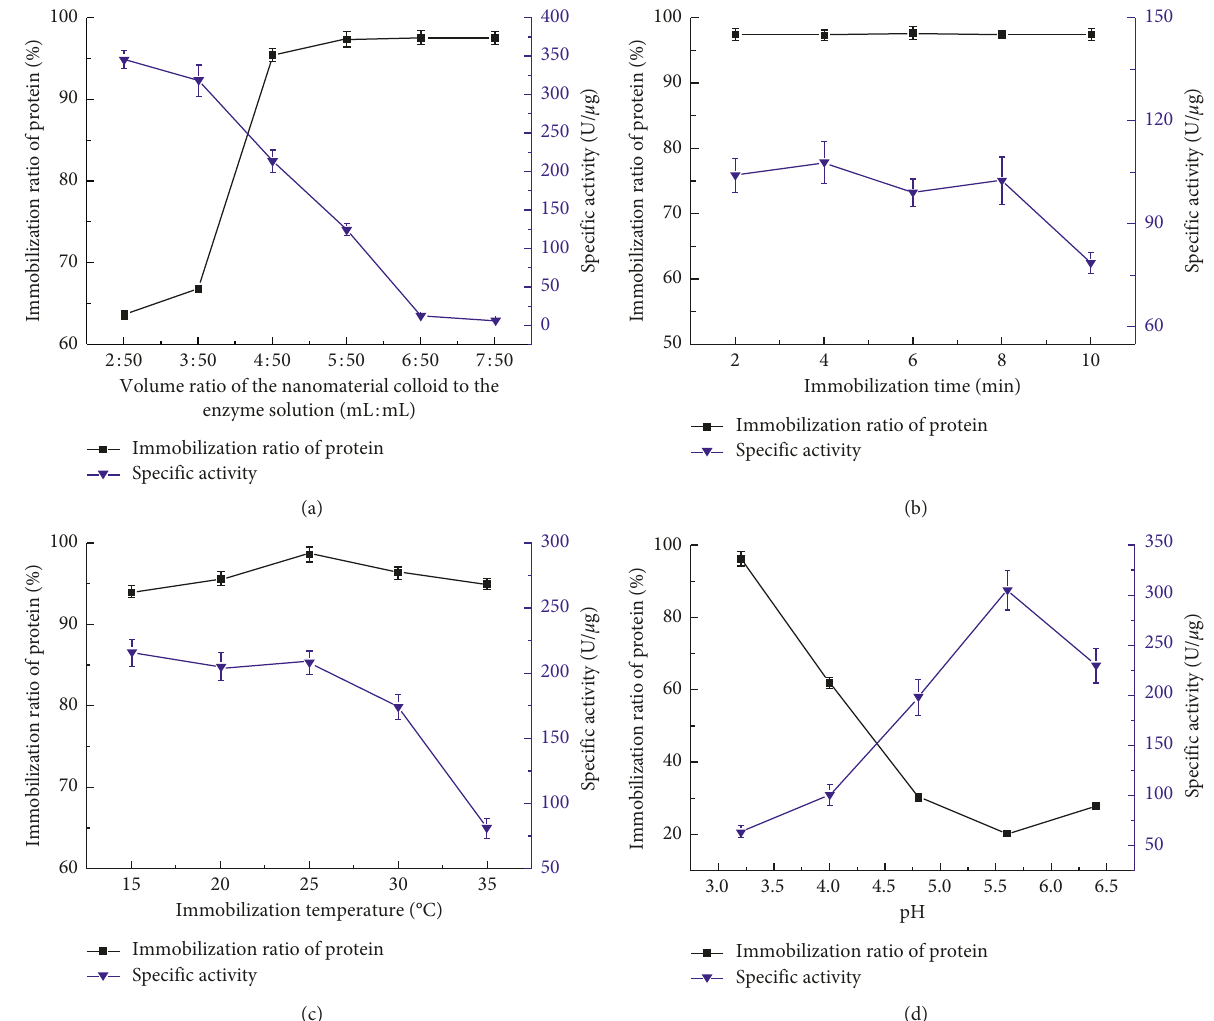
Figure 8: Influence of the volume ratio of the nanomaterial to the enzyme solution (a), immobilization time (b), temperature (c), and pH (d) on